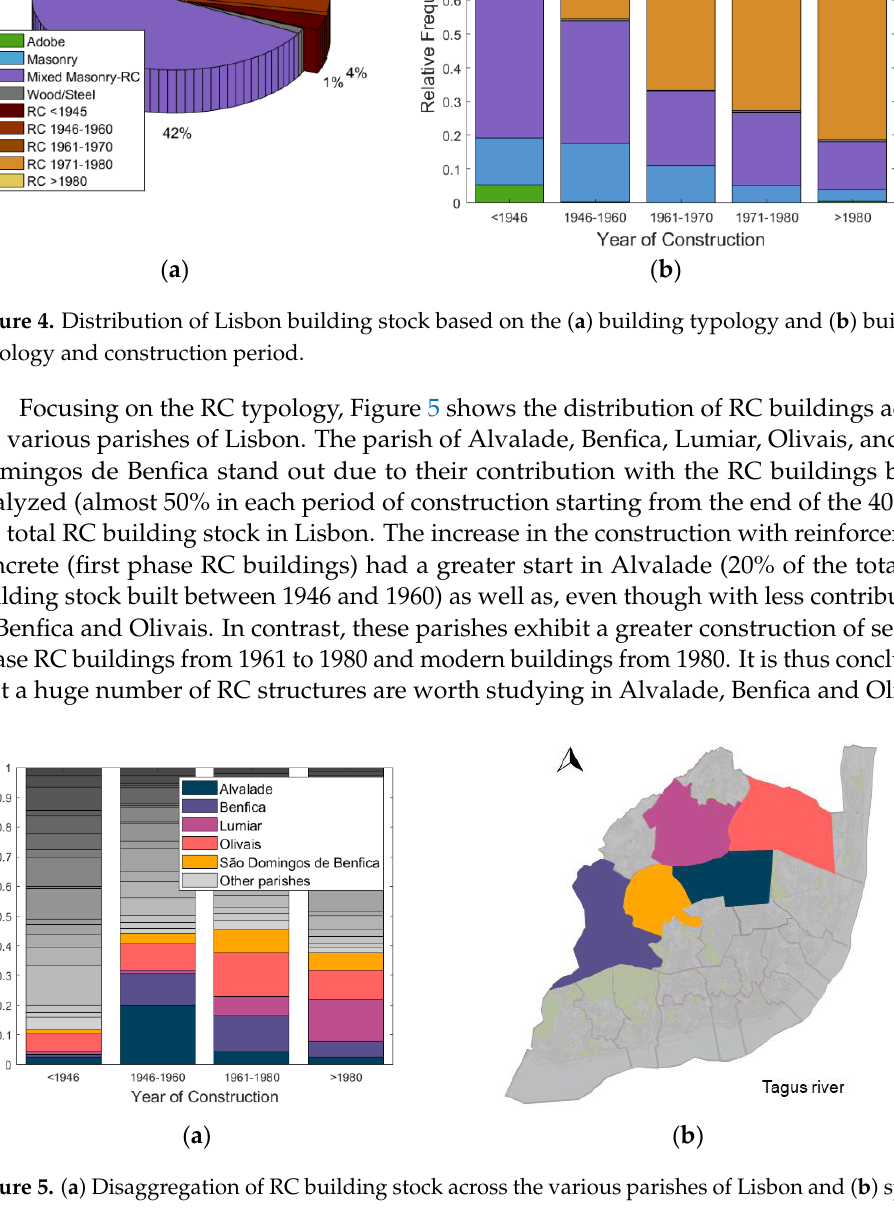
Figure 5. ( a ) Disaggregation of RC building stock across the various parishes of Lisbon and ( b ) spa- tial location of these parishes in Lisbon district.